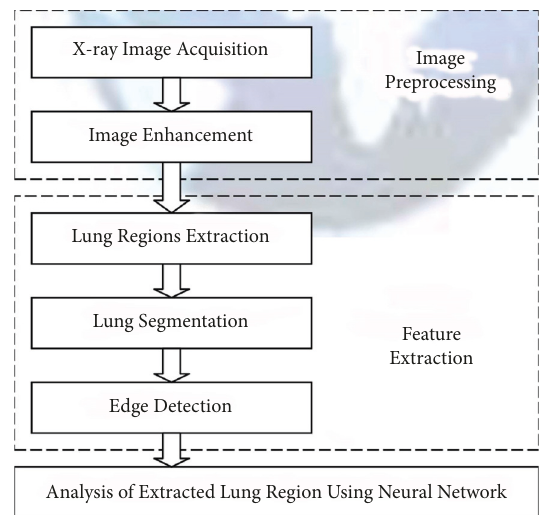
Figure 4: Framework for lung cancer detection by applying the blockchain CNN method